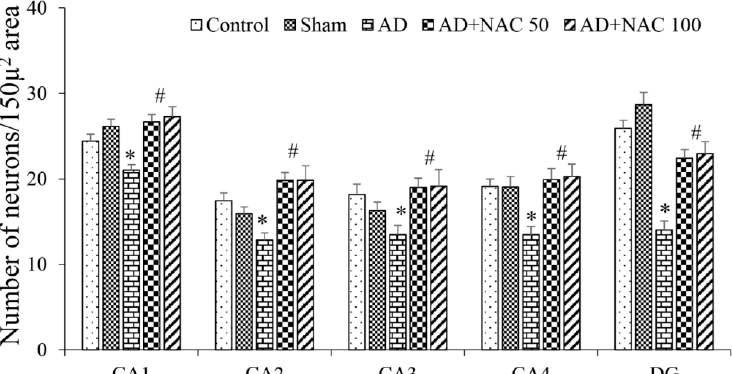
Figure 2. Quantitative estimation of normal neurons in various regions of the hippocampus. In the CA1, CA2, CA3, & CA4 regions, a length of 350 µm was selected; in the dentate gyrus (DG), 150 µ 2 was selected for quantification. Note that in all regions, the number of neurons decreased significantly in AD group compared to control and Sham group, and was increased in AD + NAC treated groups compared to AD group. Values are expressed as mean ± SE. Control/sham vs. AD: *, p < 0.05–0.001; AD vs. AD + NAC 50 or AD vs. AD + NAC 100: #, p < 0.01 (One-way ANOVA, Bonferroni’s multiple comparison test, n = 6 in all groups).